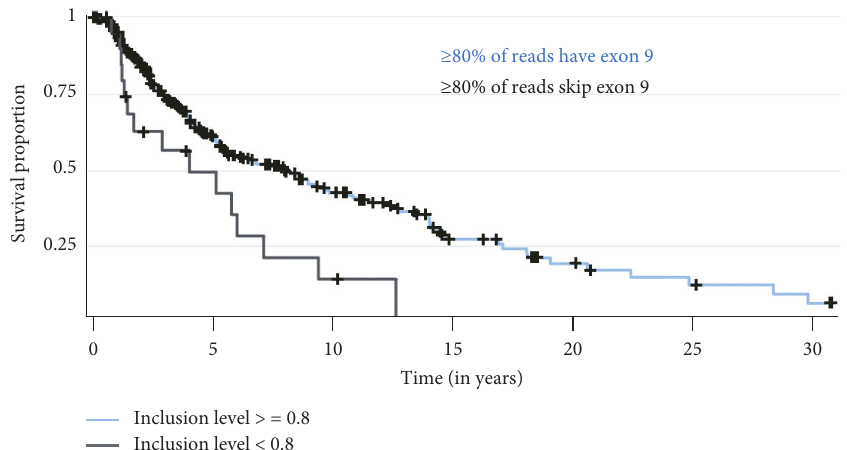
Figure 6: MDM4-A isoform correlates with poor survival. The subjects with an exon 9 percent spliced in (PSI) greater than 0.8 (indicating inclusion of exon 9 seen in ≥ 80% of transcripts, n � 323) had significantly higher survival than subjects where ≥ 80% of transcripts skipped exon 9 ( n � 22, log-rank p value � 0.00472).